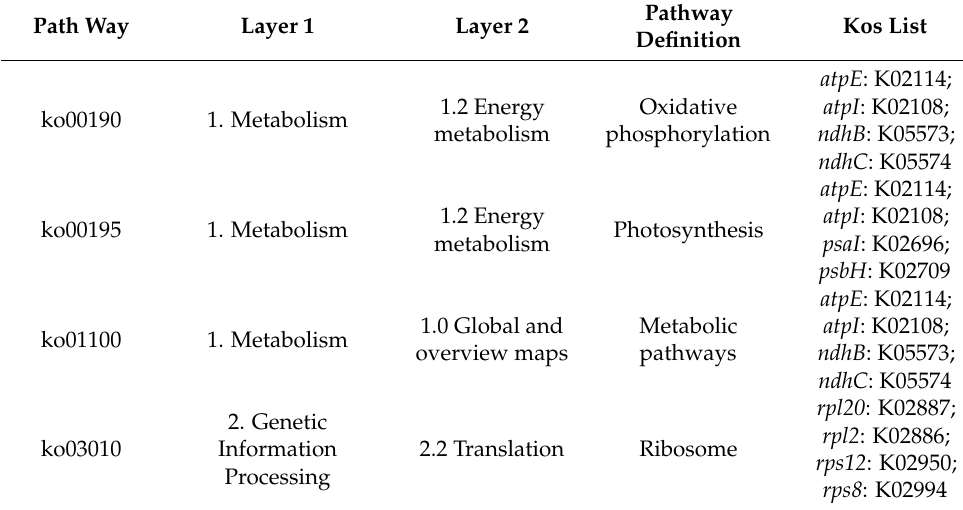
Table 9. Related pathway analysis of 11 positive selection